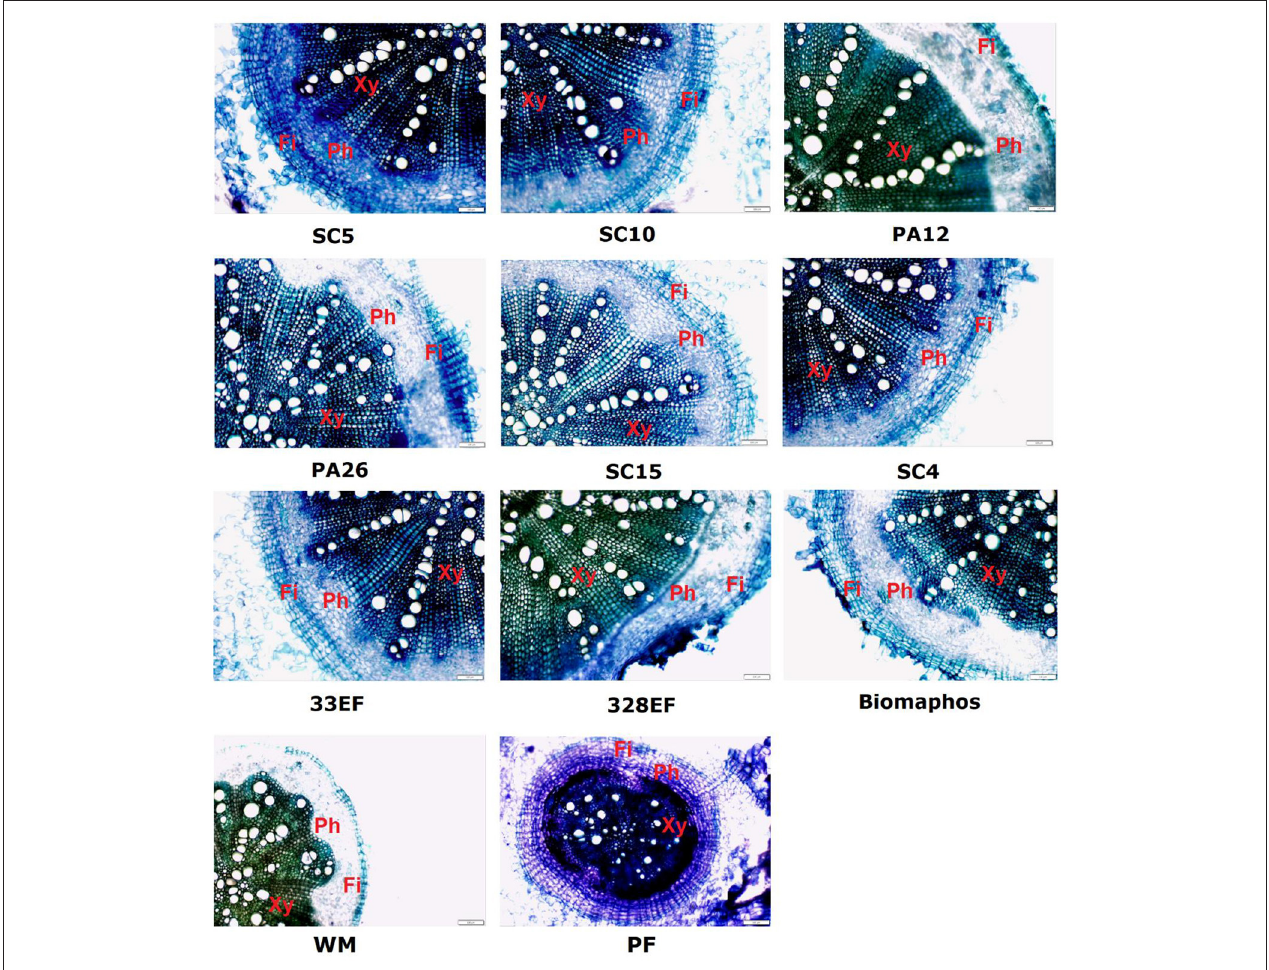
FIGURE 8 | Cross-sections showing different anatomical regions (Xy, Xylem; Ph, Phloem; Fi, Fibers) of soybean roots ( G. max ) grown in nutrient solution providing calcium phosphate (CaHPO 4 ) as a phosphate source and inoculated with four bacterial strains and four fungal strains. SC5, B. cereus ; SC10, B. thuringiensis ; PA12, P. alvei ; PA26, L. fusiformis ; SC15, P. sheari ; SC4, E. keratinophilum ; 33EF, H. insecticola ; 328EF, Codinaeopsis sp.; Biomaphos ® , B. megaterium and B. subtilis ; WM, without microorganisms; PF,